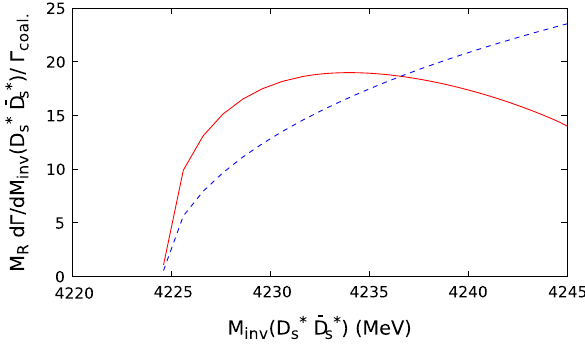
d (cid:8) i Fig. 9 The M R (cid:8) as a function of M in v ( D ∗ s ¯ D ∗ s ) for the B c → dM inv coal + X ( 4160 ) decay. The dashed line corresponds to phase ν l l